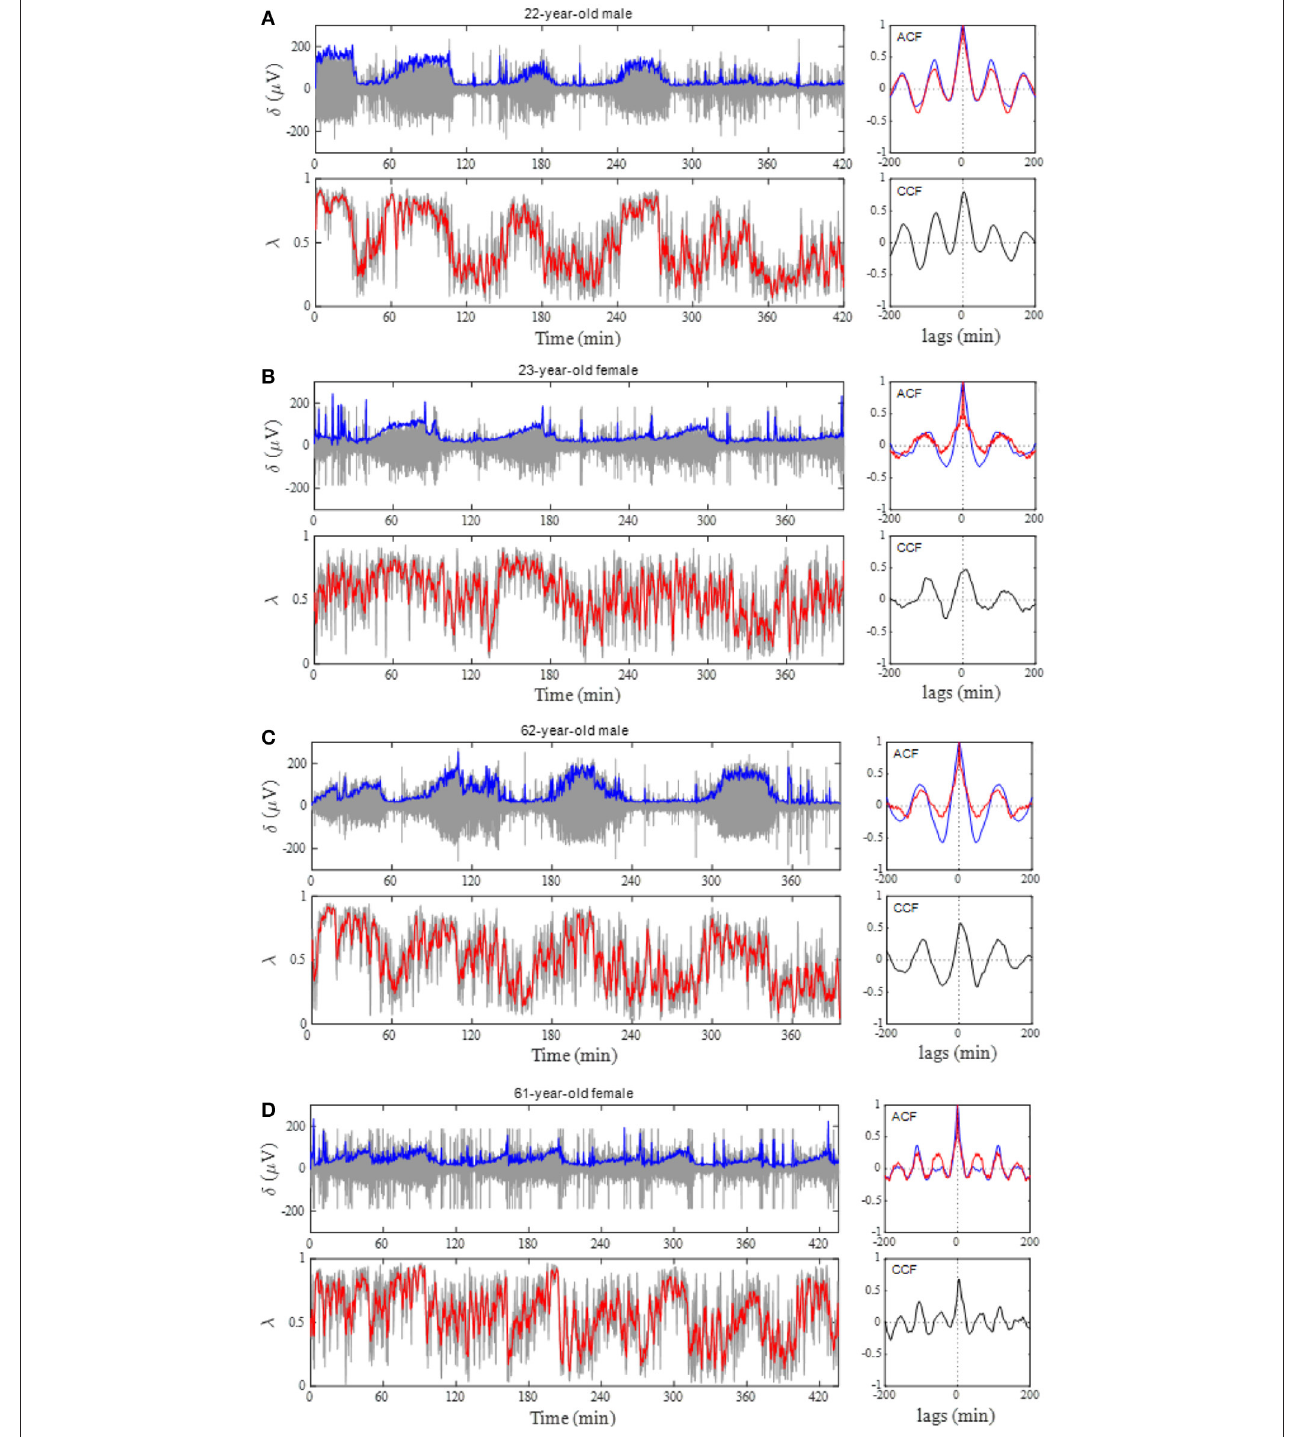
FIGURE 5 | Phase coupling analyses for male and female subjects of different ages. (A) 22-year-old man, (B) 23-year-old woman, (C) 62-year-old man, and (D) 61 year-old woman. Profiles of the EEG δ -wave and phase coherence ( λ ) for the whole night are shown, together with their respective autocorrelation function (ACF) and cross-correlation function (CCF) between these two signals. Blue and red curves in the ACF panel indicate ACF for the δ -wave and λ , respectively. Depicted in the gray and blue in δ -wave panel show an extracted δ -wave and its envelope, respectively. Computed λ from 20-s windows shows in gray line and the red indicates general trend obtained by applying a median filter (2-min moving